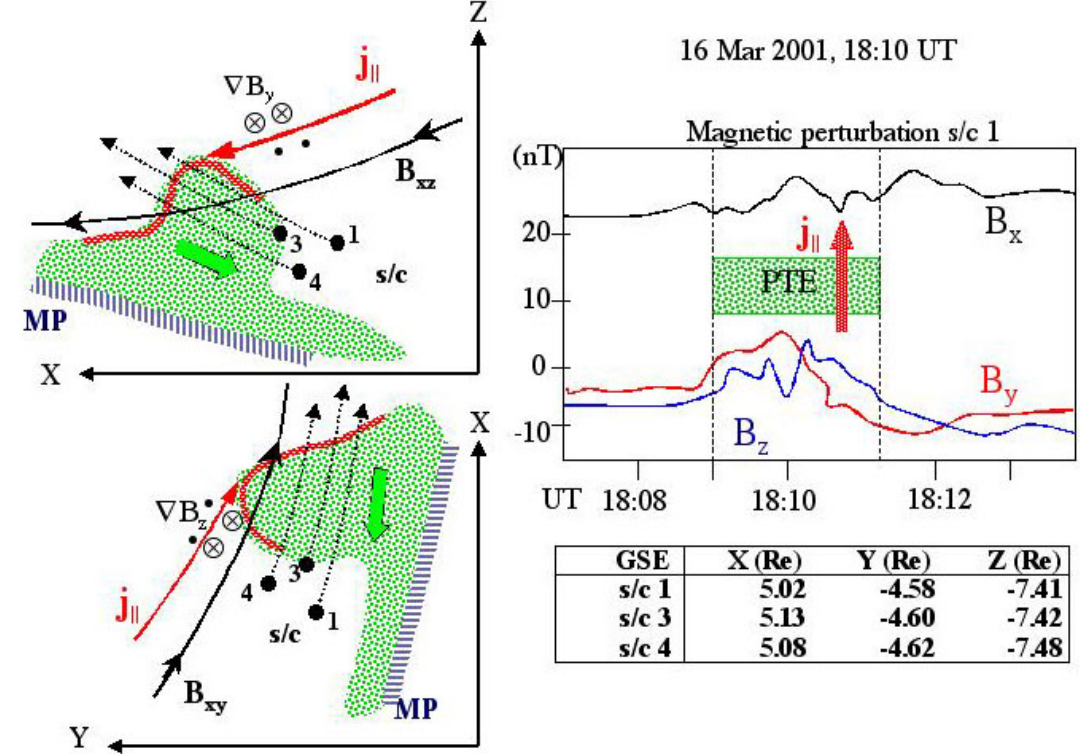
Fig. 9. Diagrammatic representation of the PTE on 16 March 2001,